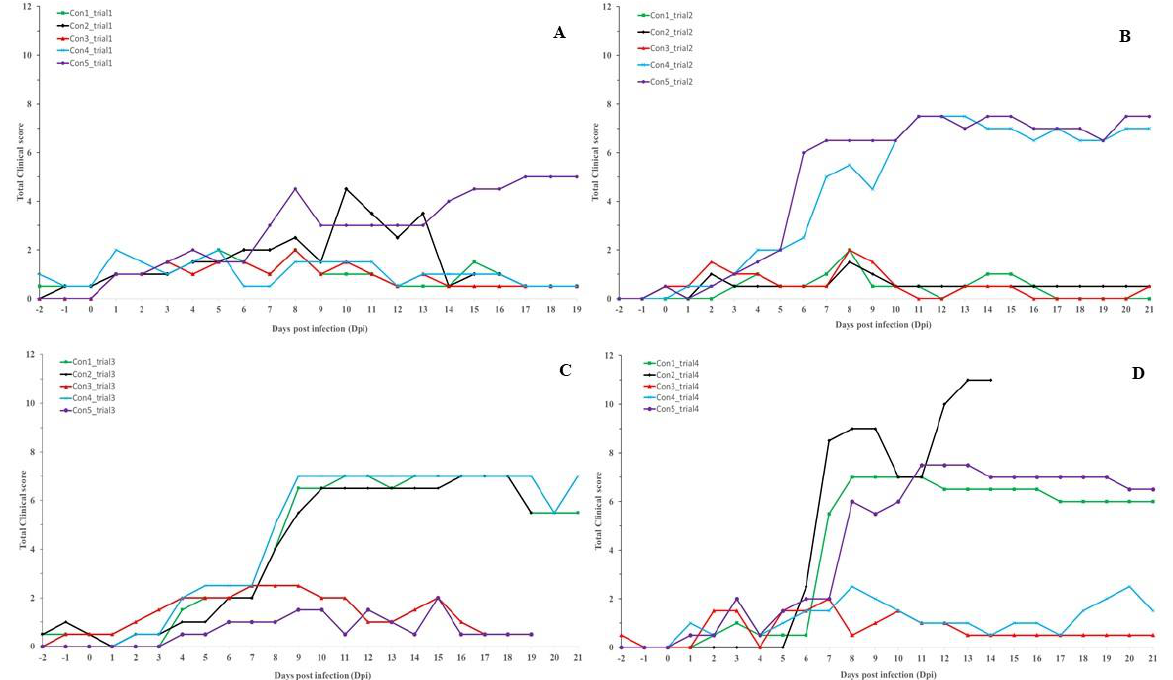
Figure 2. Total clinical score of the control animals. Infected at 0 dpi; ( A ): Trial 1; ( B ): Trial 2; ( C ): Trial 3; ( D ): Trial 4.